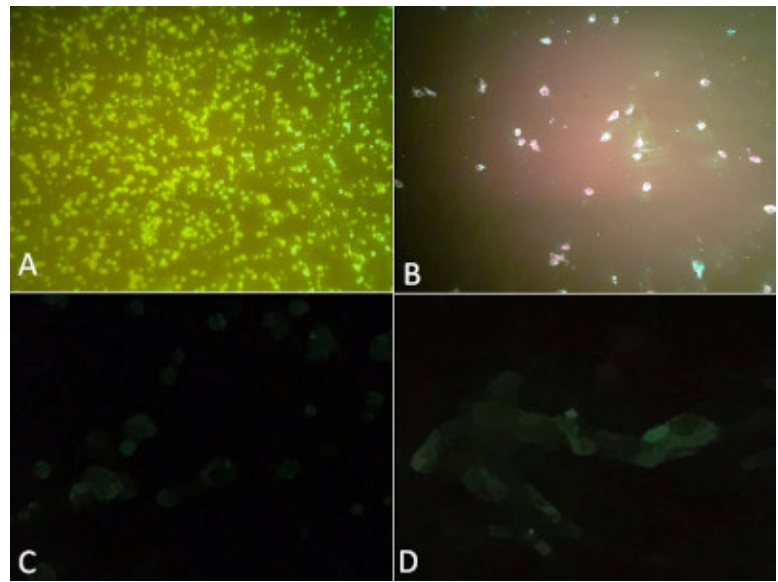
Figure 2. C6/36 and VERO cell cultures inoculated with the BeAR865640 sample, positive in the IFF test. ( A ) positive C6/36; ( B ) positive VERO; ( C ) C6/36 negative control; ( D ) VERO negative